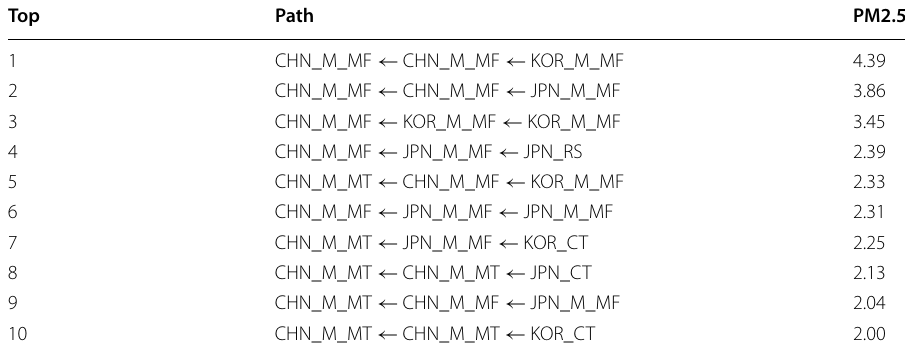
Table 10 Top 10 paths of trans-boundary PM2.5 emission (in kt) Top Path